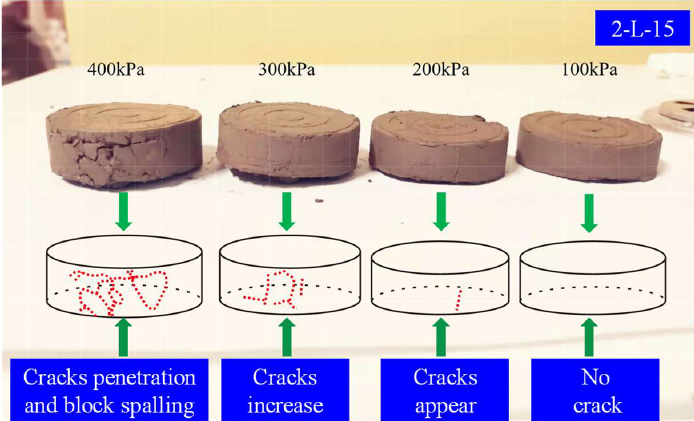
Figure 7. Stress concentration of the CPB.